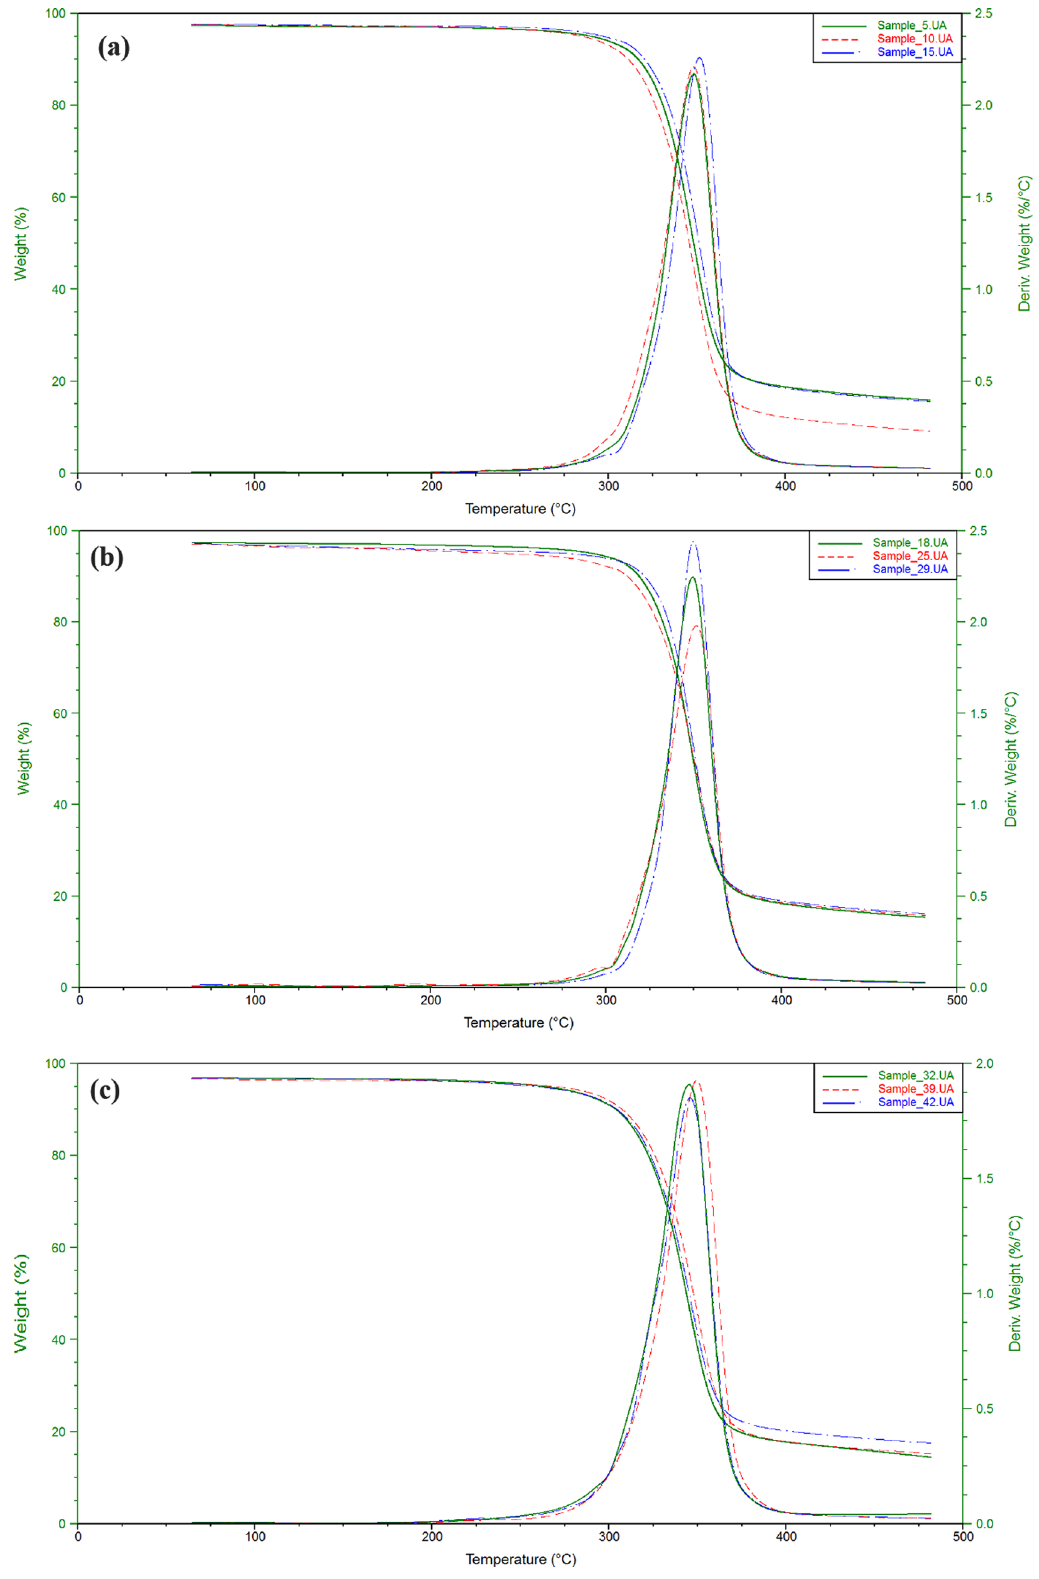
Figure 3. TGA and DTA analysis of ( a ) Samples 5 , 10 , 15 ; ( b ) Samples 18 , 25 , 29 ; ( c ) Samples 32 , 29 , 42 ; ( d ) Samples 48 , 51 , 57